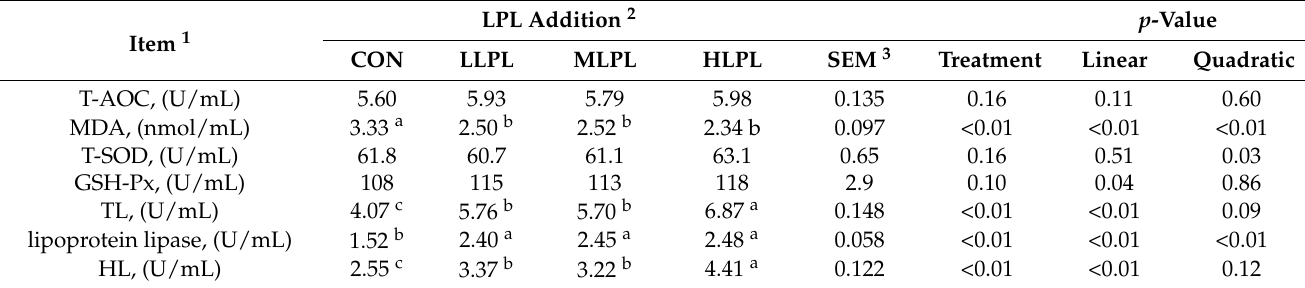
Table 5. Effect of dietary lysophospholipid supplementation on the antioxidant function and enzyme activities of beef